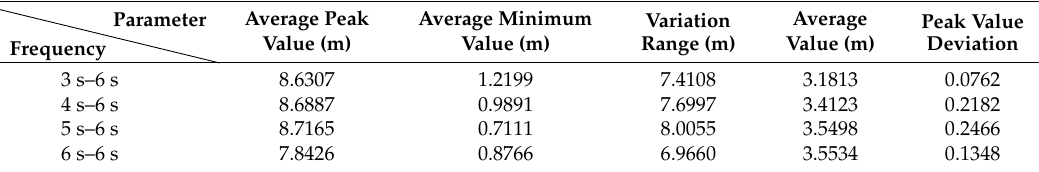
Table 1. Pressure values and statistical analysis after air inflow has been cut off for 6 s (round nozzle in the middle of the pipe).